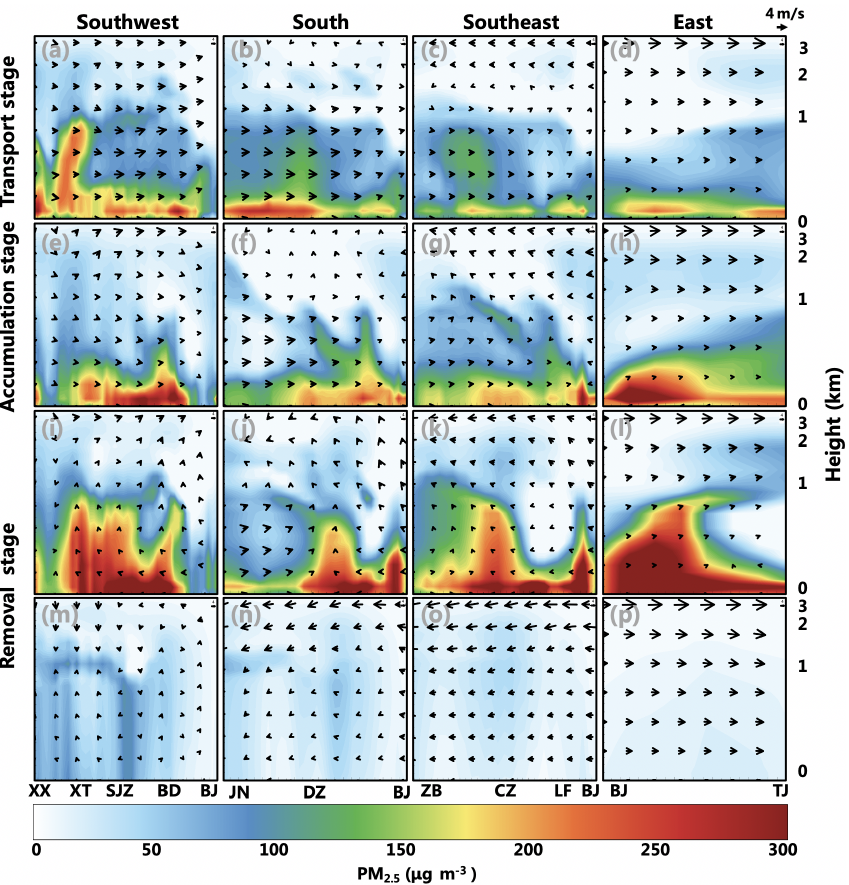
Figure 8. Vertical profiles of PM 2 . 5 cross sections with wind vectors along the transport pathways, including southwest (a, e, i, m) , south (b, f, j, n) , southeast (c, g, k, o) , and east (d, h, l, p) . The first row (a–d) (00:00LT 2 December 2017) represents the transport stage, the second row (e–h) (10:00LT 2 December 2017) represents the accumulation stage, and the third row (i–l) (00:00LT, 3 December 2017) and fourth row (m–p) (14:00LT, 4 December 2017) represent the removal